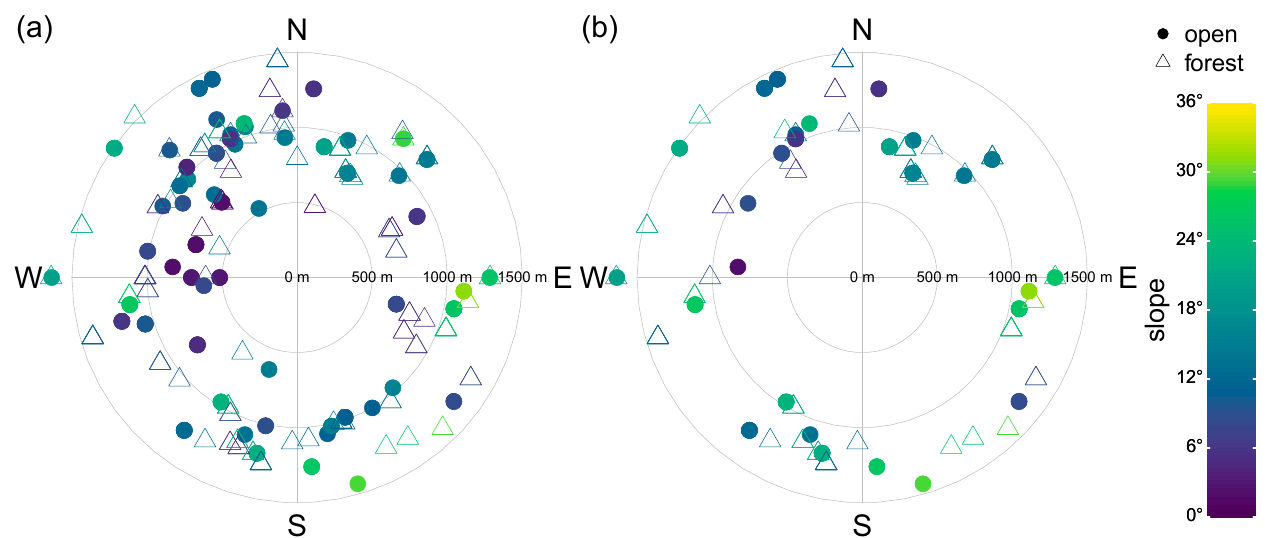
Figure 1. Overview of the study areas. Figure created with QGIS 3.16.1. DEM data based on viewfinderpanoramas.org.